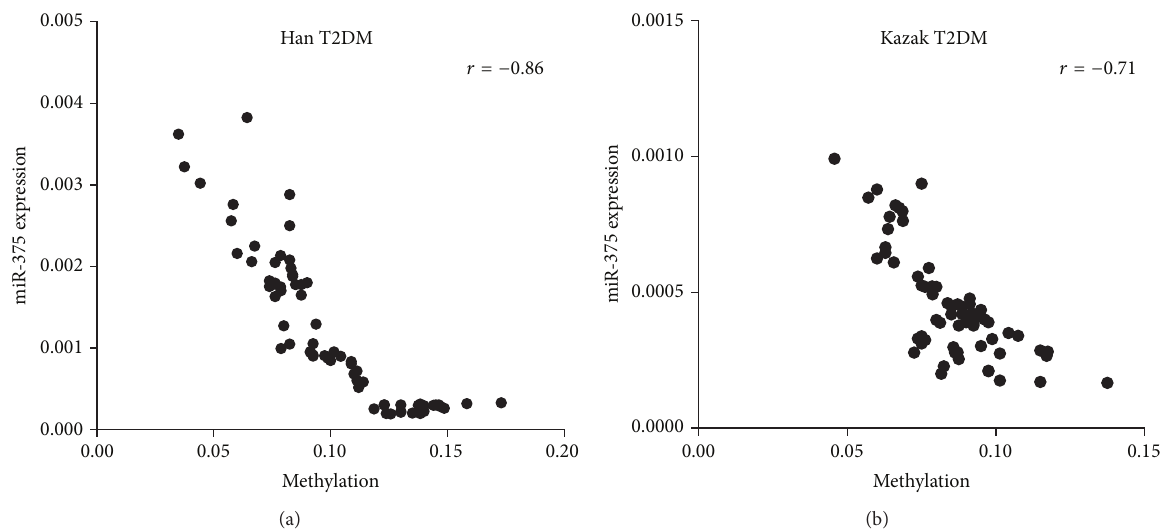
Figure 6: The correlation analysis between CpG methylation levels of miR-375 promoter and plasma levels of miR-375. An inverse correlation for clear trend towards a negative correlation between DNA methylation levels and plasma levels of miR-375 is shown for each of the two sample sets: (a) Kazak T2DM and (b) Han T2DM. Spearman correlation coefficients are reported. 𝑃 values for both samples are significant ( 𝑃 < 0.001